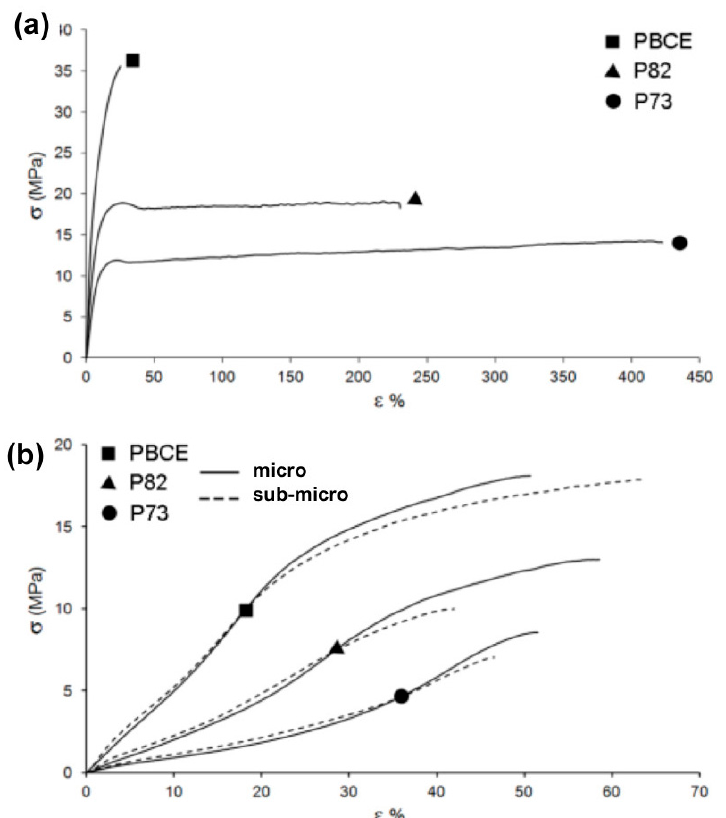
Figure 2. Substrate mechanical properties. Representative stress–strain curves of PBCE (square), P82 (triangle), and P73 (circle): ( a ) films and ( b ) electrospun scaffolds with micrometric fibres (solid line) and sub-micrometric fibres (dashed line).